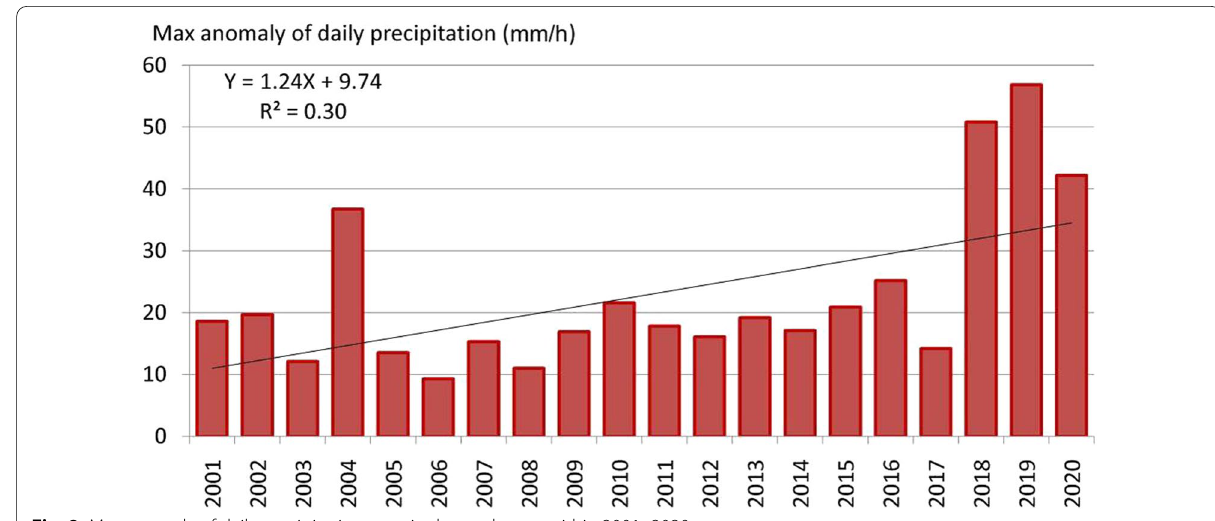
Fig. 8 Max anomaly of daily precipitation rates in the study area within 2001–2020